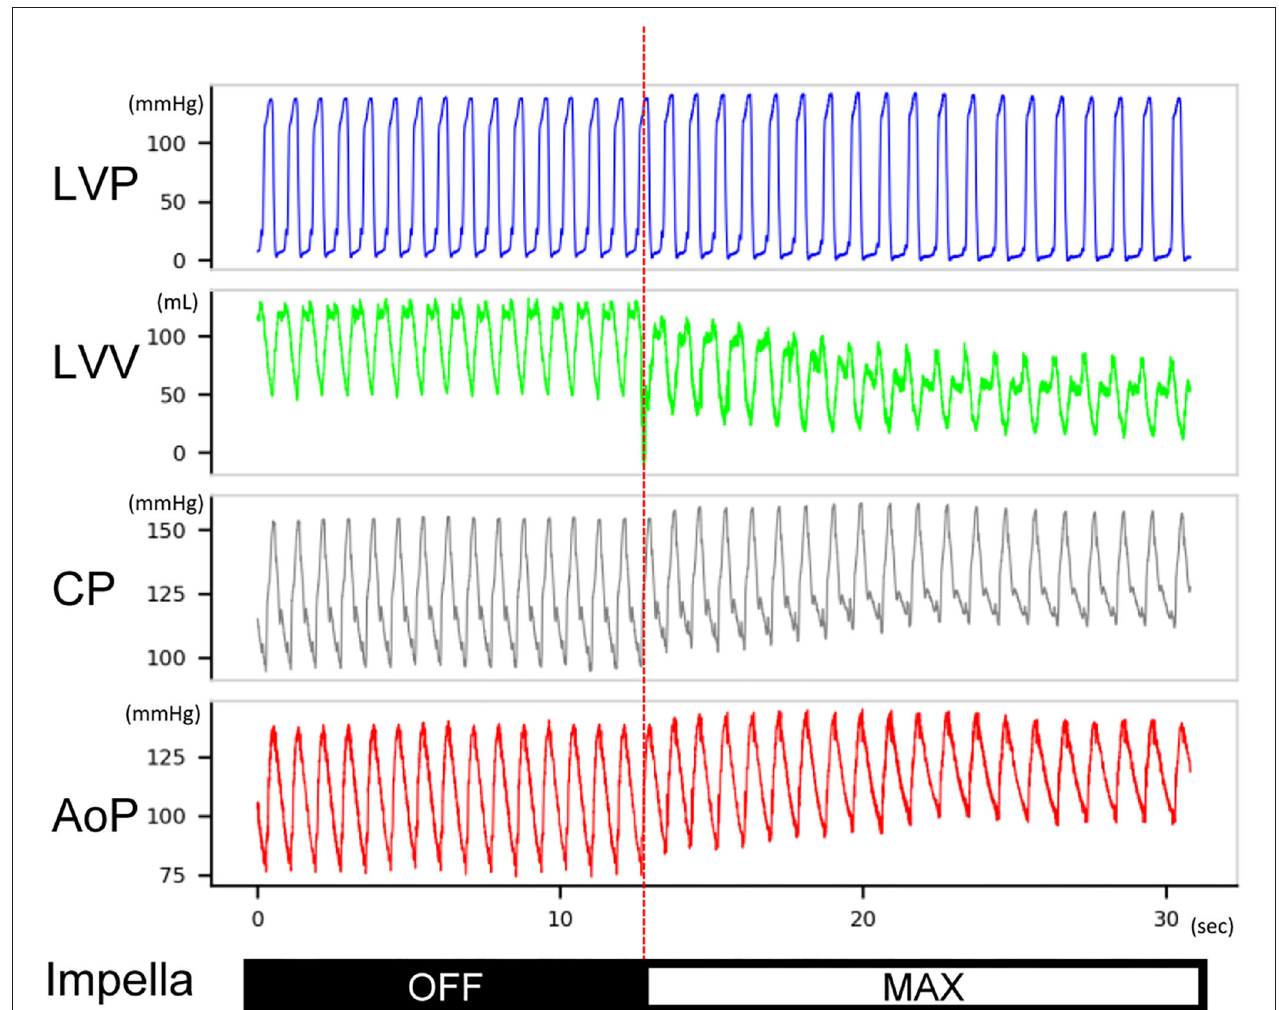
FIGURE 4 | Typical hemodynamic traces of Impella LV support on a heart with non-flow-limiting coronary dissection. After Impella was turned on, the left ventricular volume decreased, the coronary mean pressure increased, and the diastolic aortic pressure increased. The length of the traces is 30s. This record was from animal #5. LVP, left ventricular pressure; LVV, left ventricular volume; CP, coronary pressure; AoP, aortic